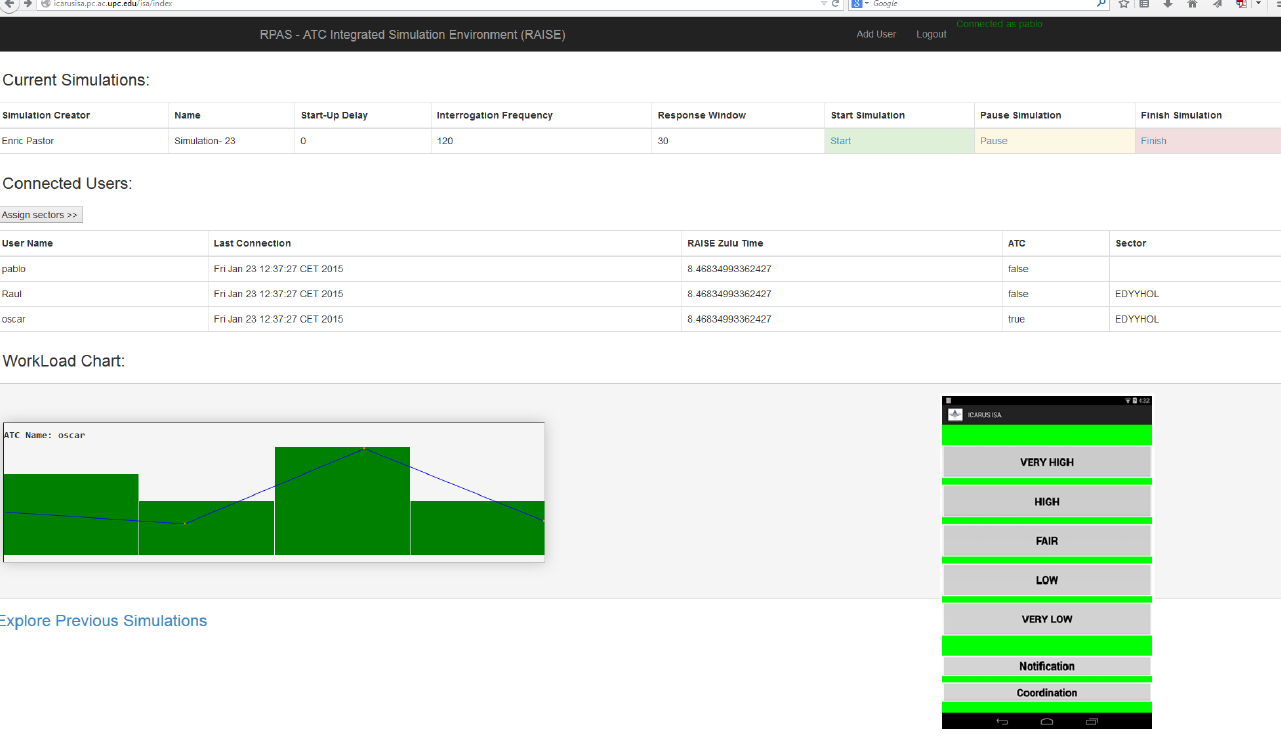
Figure 3. ISA management interface employed in the ERAINT project.